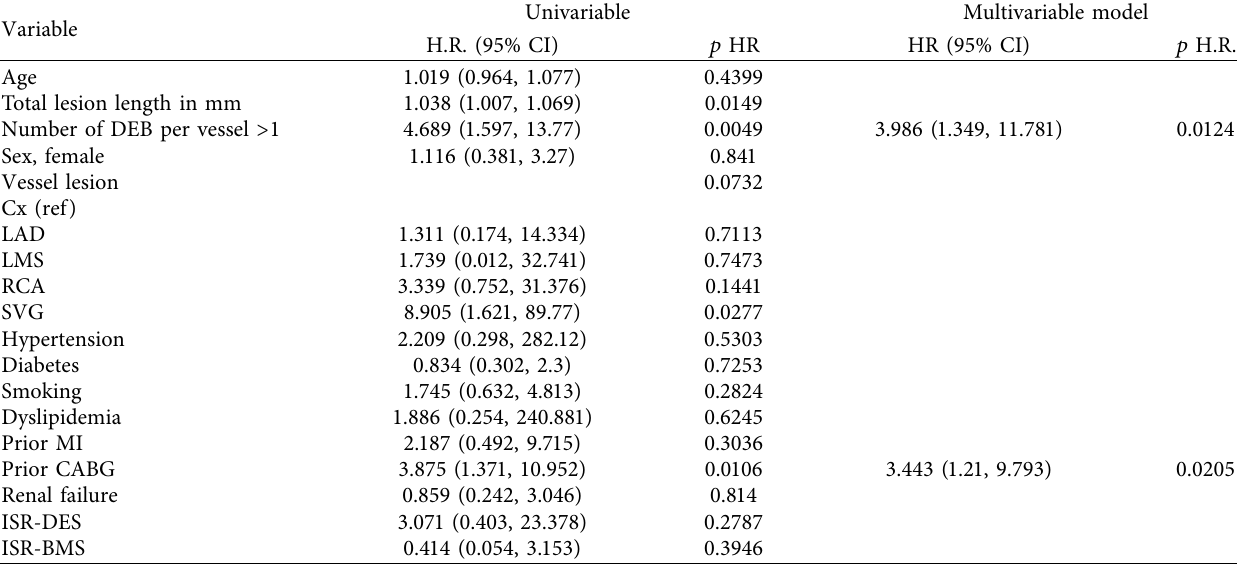
Table 8: Univariable and multivariable cause-specific Cox proportional hazard (H.R.) for